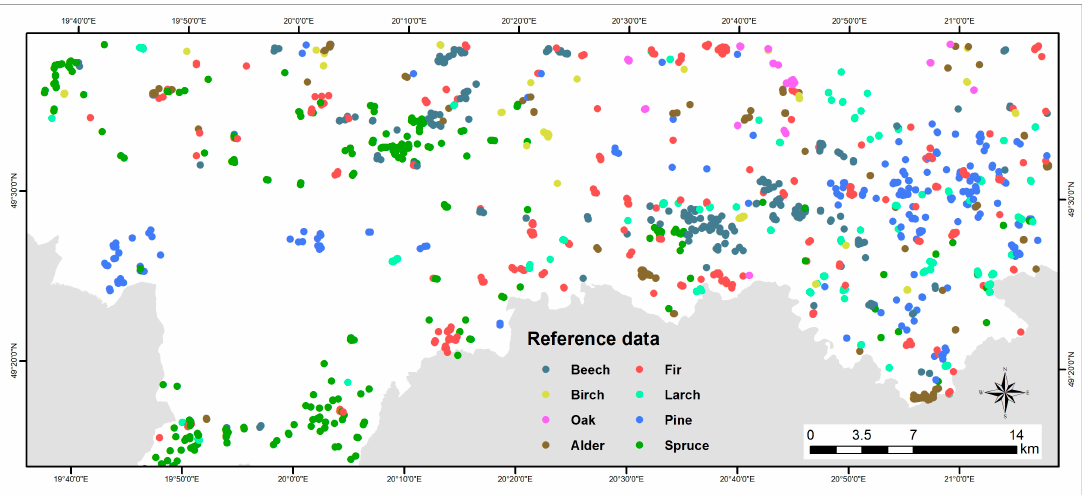
Figure 4. Locations of the reference samples coloured by tree species.